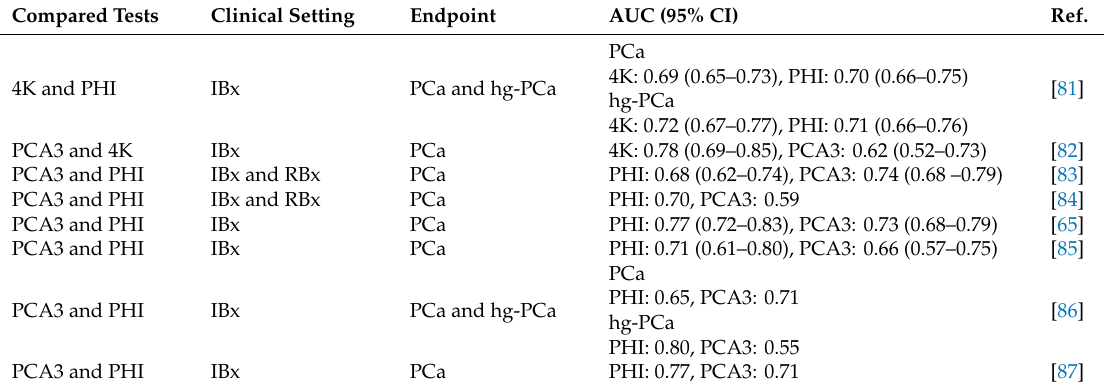
Table 3. Comparative head-to-head studies comparing biomarker tests for prostate cancer. Compared